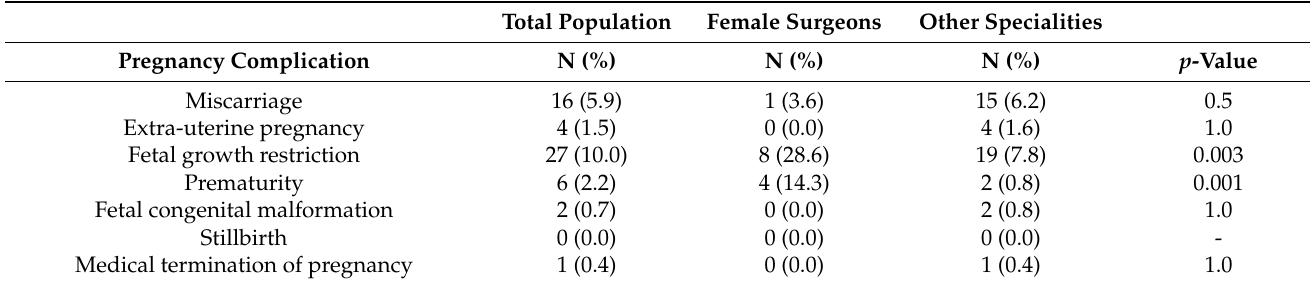
Table 2. Pregnancy complications among 270 female physicians.